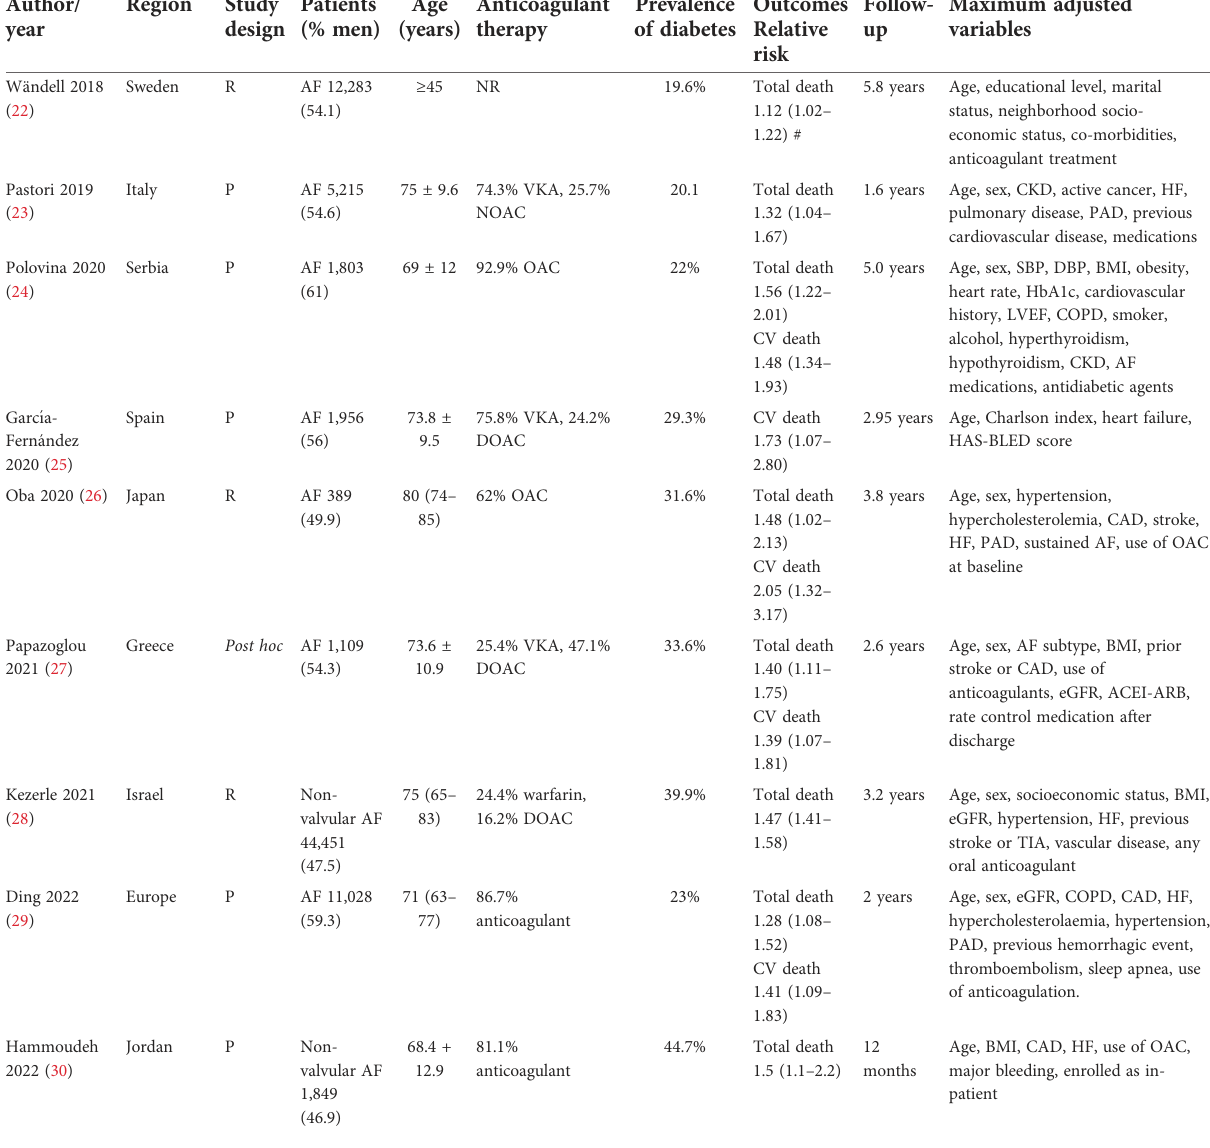
(Supplementary Figure S1). Additionally, signi fi cant associations of diabetes mellitus with all-cause mortality were consistently observed in each subgroup (Table